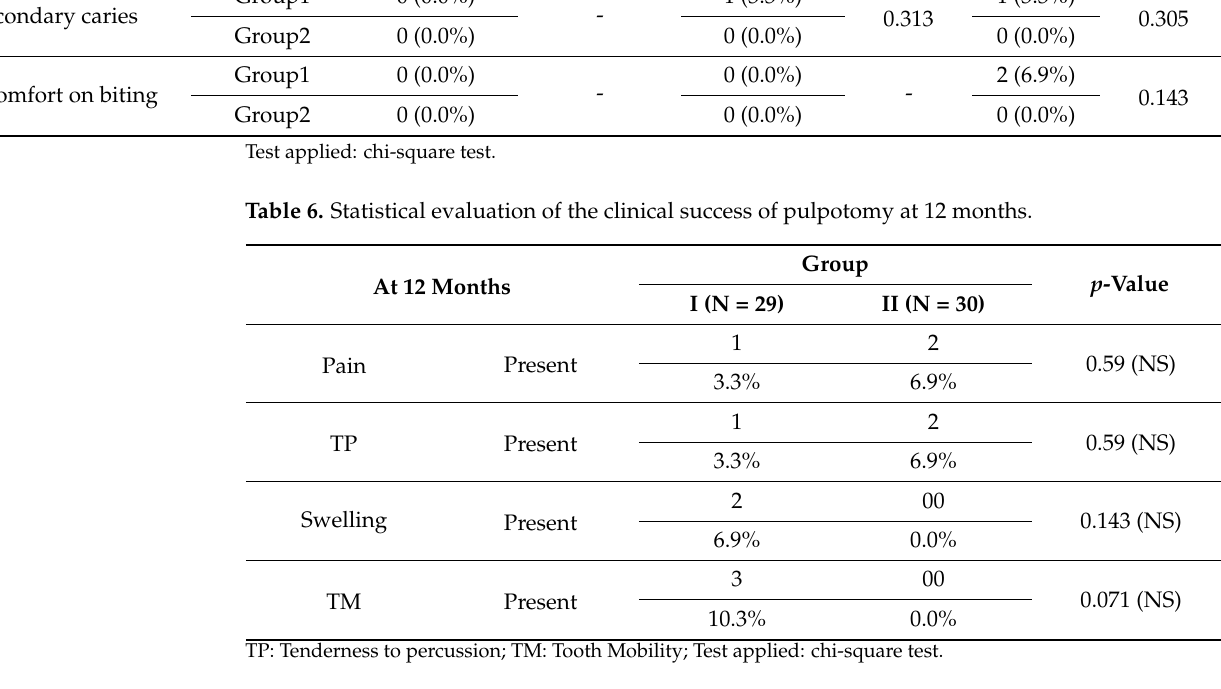
Table 7. Statistical evaluation of the radiographic success of pulpotomy at 12